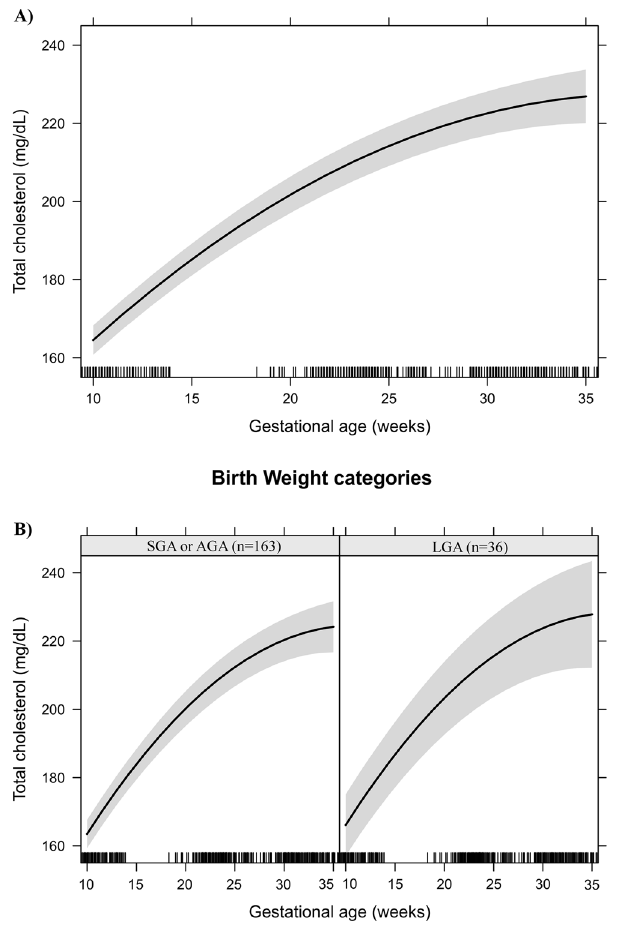
Figure 3. Total cholesterol changes during pregnancy in a sample of 199 women and their newborns followed at a public health centre in Rio de Janeiro city, Brazil, 2009–2012. ( A ) Change per gestational week. ( B ) Change per gestational week according to birth weight categories. Note: The models were adjusted for age, education, smoking habit, pre-pregnancy leisure time physical activity, pre-pregnancy energy intake, glycaemia, parity, early pregnancy BMI, gestational weight gain and quadratic gestational age. Data are presented as linear mixed effect coefficient ( β ) and 95% CI. p-value refers to the maximum likelihood estimator.( A ) Linear gestational age: β = 6.21 (5.36; 7.05), p < 0.001; Quadratic gestational age: β = − 0.085 ( − 0.10; − 0.07), p < 0.001. ( B ) SGA or AGA - Linear gestational age: β = 5.88 (4.98; 6.78), p < 0.001; quadratic gestational age; β = − 0.08 ( − 0.10; − 0.06), p < 0.001. LGA - Linear gestational age: β = 7.67 (5.50; 9.83), p < 0.001; gestational age; β = − 0.12 ( − 0.17; − 0.07), p <